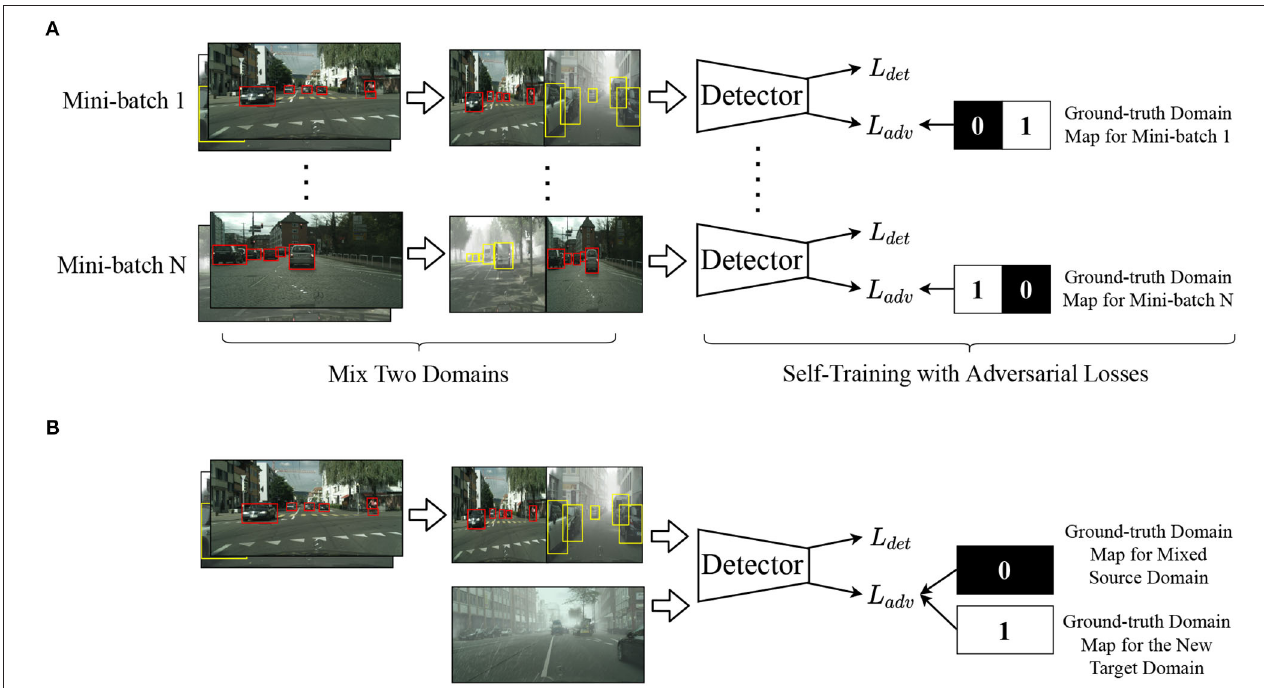
FIGURE 4 | (A,B) Illustration of the “Recall” and “Adapt” stage. In the first “Recall” stage, boxes in red and yellow represent ground-truth labels of the source domain and pseudo labels of the latest target domain, respectively. In the second “Adapt” stage, we consider the mixed source domain as the source domain and complete adaptation. Black and white in the ground-truth domain maps signify the source domain (0) and the target domain (1).